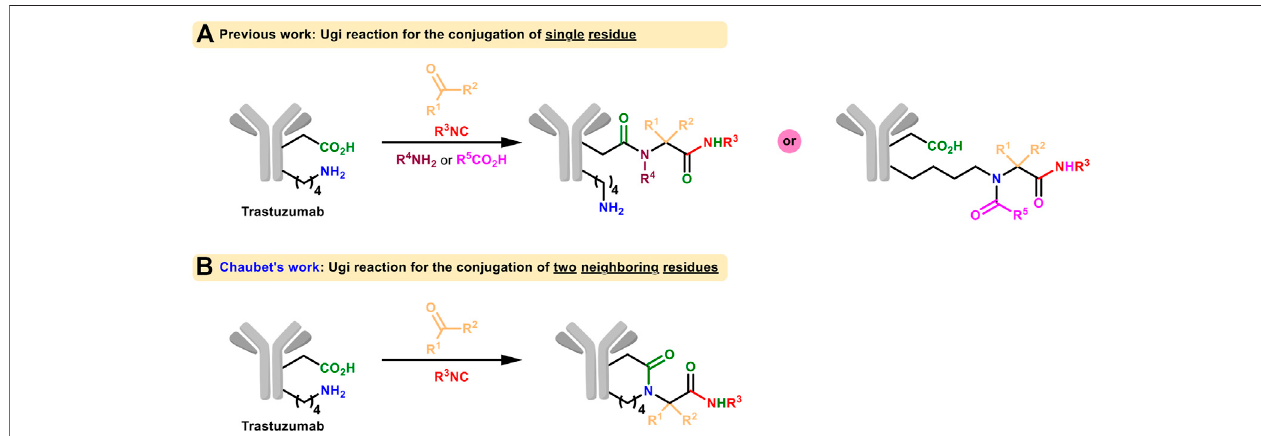
FIGURE 7 | (A) Ugi reaction for the conjugation of single residue of native proteins. (B) Ugi reaction for the conjugation of two neighboring residues of native proteins.